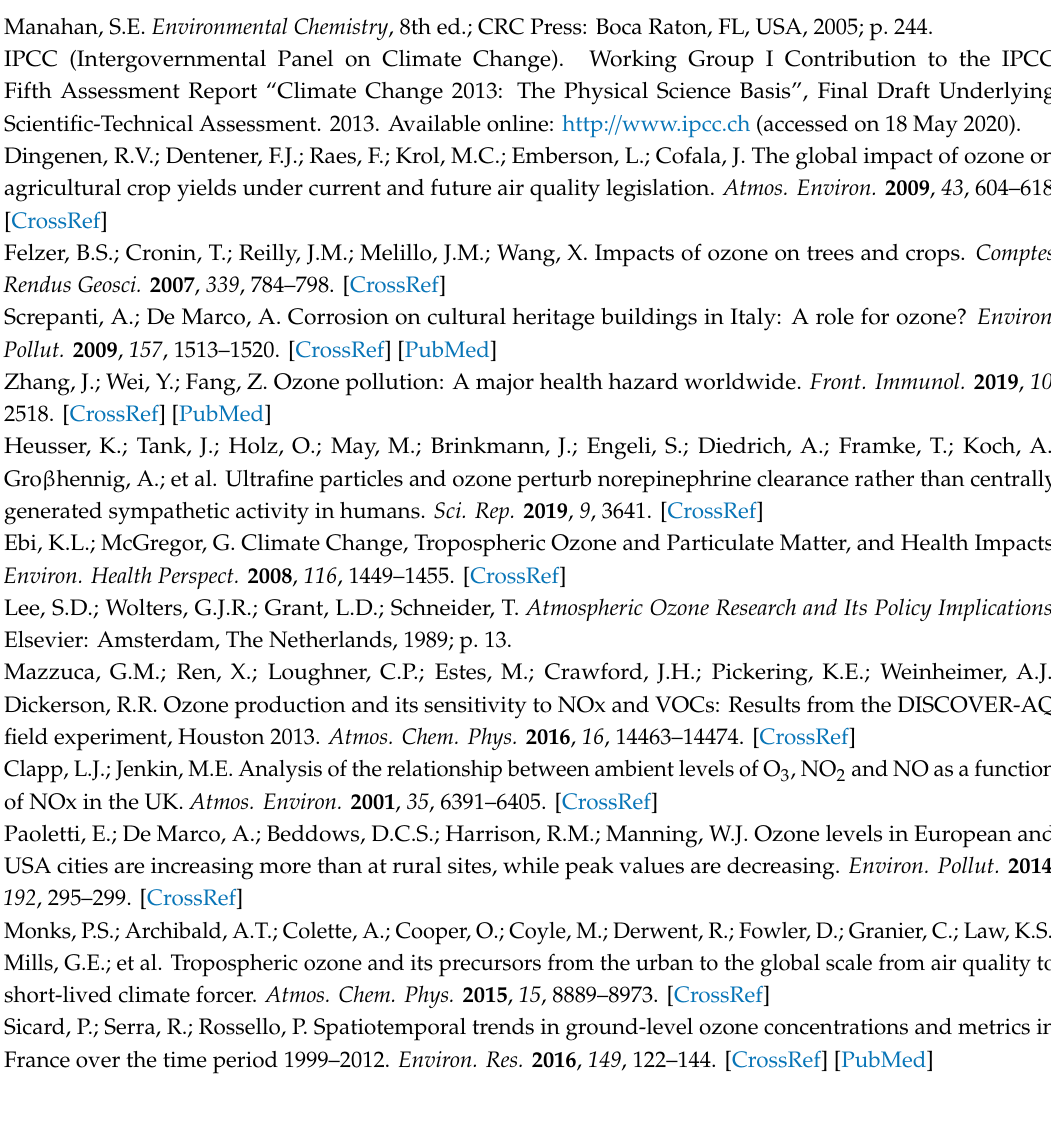
Table S1: The annual average ozone maximum and the trend of maximum ozone and average ozone for the period of 1992–2019. Figure S1: Monthly ozone exceedances in rural sites for last three decades, (a) 1990s, (b) 2000s and (3) 2010s. Figure S2: Monthly ozone exceedances in urban sites for last three decades, (a) 1990s, (b) 2000s and (3) 2010s. Figure S3: Trajectories arriving in Birmingham Centre (Bi), Cardi ff Centre (CaC) and Leeds Centre (LeC) at 4 pm (local time) on 11 May 2008. Figure S4: Trajectories arriving in Eskdatemuir (Ek), Aston Hill (AH) and Lough Navar (LN) at 4 pm (local time) for the period of 17 April to 24 April